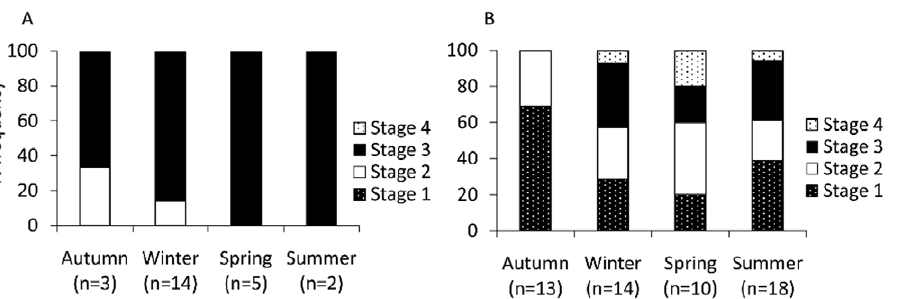
Figure 3. a–b. Seasonal frequency of maturity stages of Octopuscyanea . Seasonal frequency of developmental maturity stages of (A) male (B) female Octopus cyanea